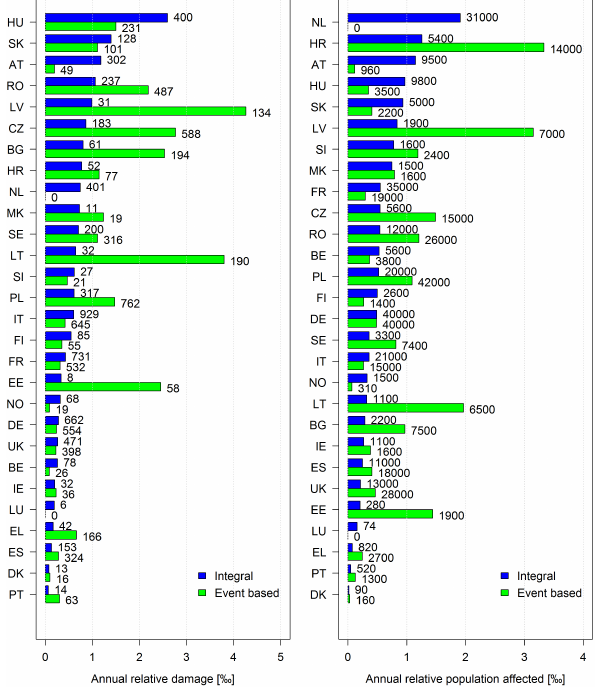
Figure 2. Annual relative damage and population affected for the considered European countries (ISO country code, see Table S2) between 1990 and 2013. Absolute figures are shown alongside each colour bar (in million Euros and people